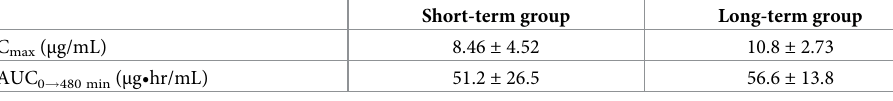
Results are shown as the means ± SD of five rats per